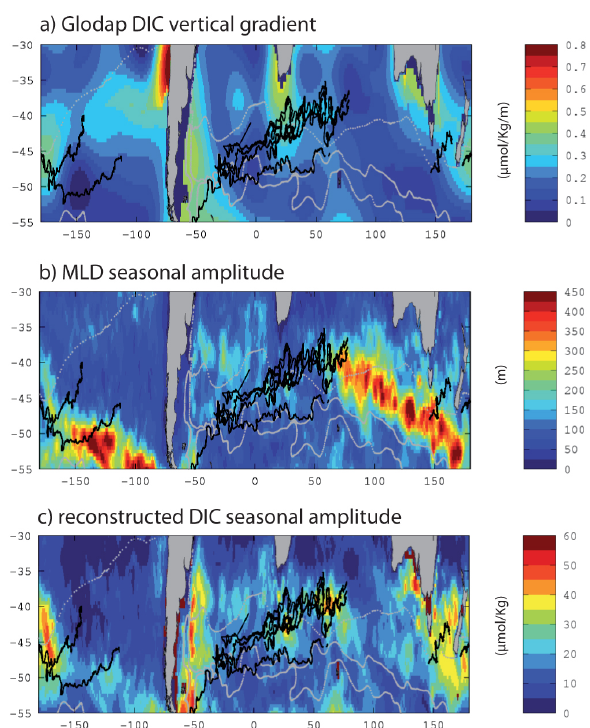
Fig. 11. (a) Vertical gradient of DIC between the surface and 200m in Glodap database; (b) seasonal amplitude (annual max–annual min) of ML depth in the climatology derived from Argo drifters of Sallée et al. (2010); (c) DIC seasonal amplitude (annual max– annual min) reconstructed by averaging Glodap annual values over the ML monthly climatology. See text Sect. 3.4 for further details.